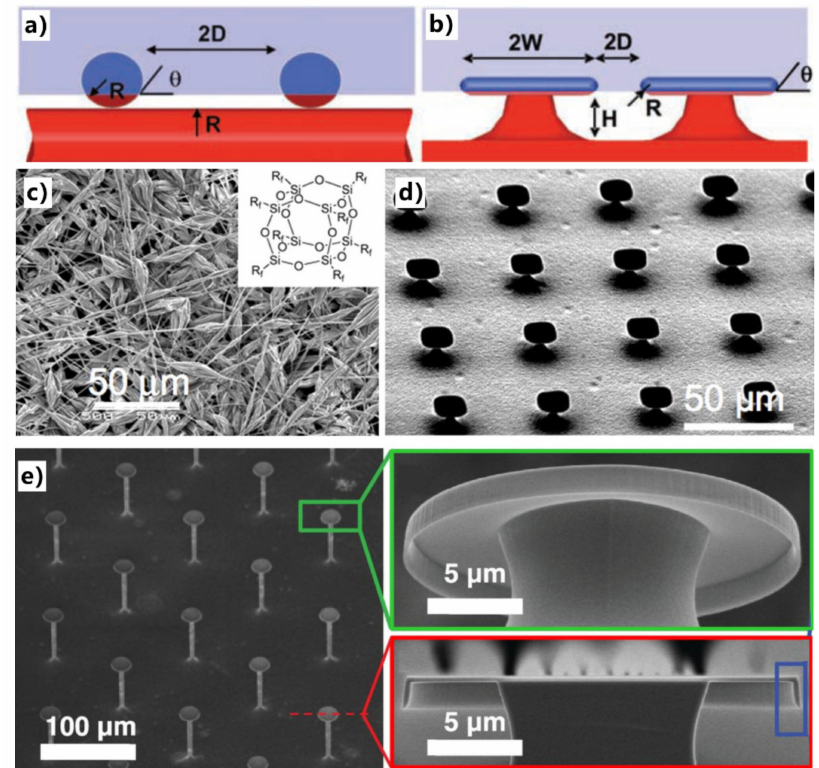
Figure 6. Superoleophobic surfaces prepared by constructing re-entrant curvature. ( a , b ) Schematic diagram of the re-entrant topography of the ( a ) fibers and ( b ) micro-hoodoos. ( c ) Morphology of the electrospun fibers. Inset: the structure of POSS molecule. ( d ) Morphology of the microhoodoo surface having square and circular flat caps. Reprinted with permission from ref. [168]. Copyright 2007, The American Association for the Advancement of Science. ( e ) SEM images of the doubly re-entrant micro- posts with vertical overhang. These superoleophobic surfaces possess re-entrant microstructures. Reprinted with permission from ref. [182]. Copyright 2014, The American Association for the Advancement of